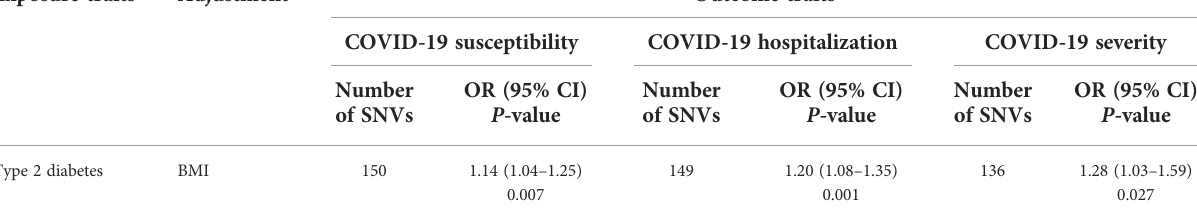
TABLE 2 IVW multivariable MR for the effects of T2DM on COVID-19 risk adjusted for BMI. Exposure